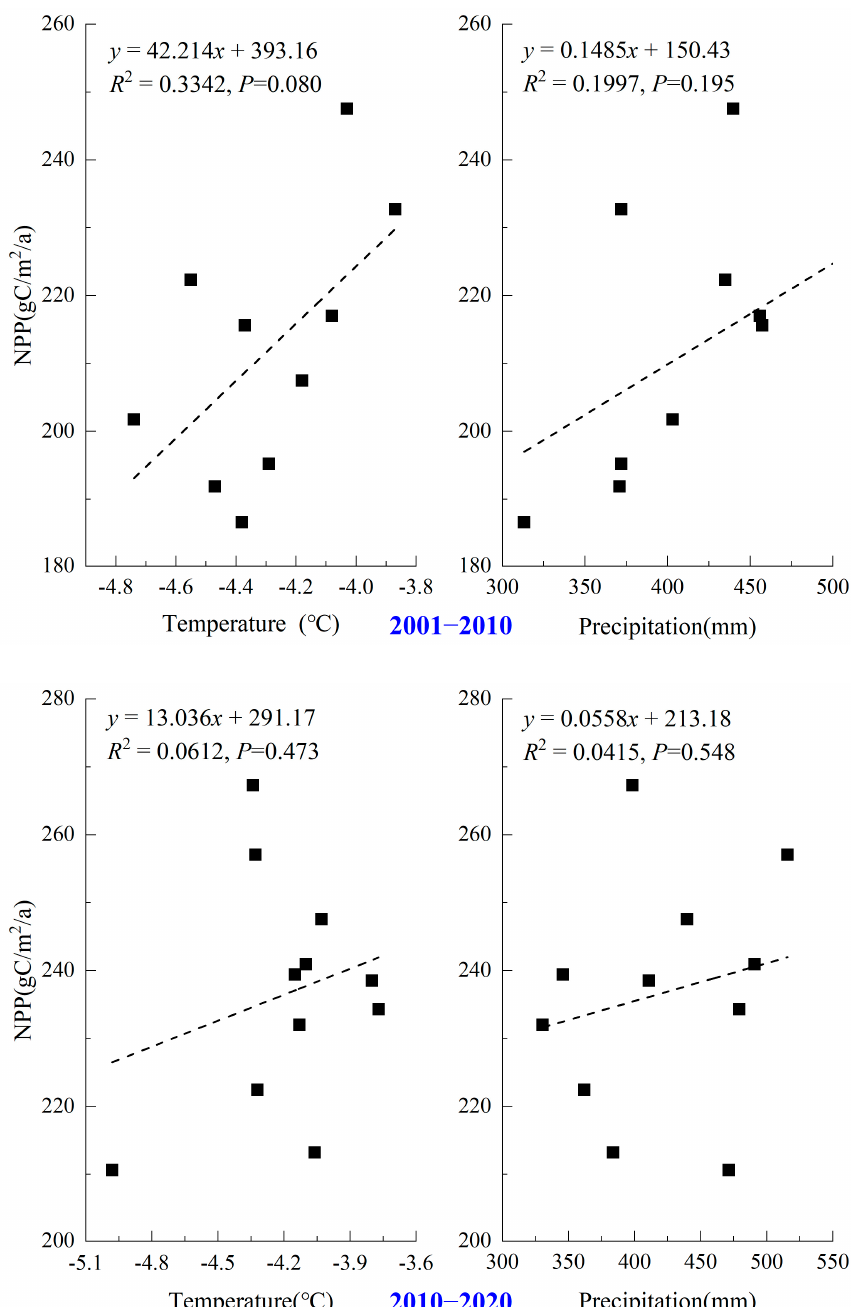
Figure 6. Scatter plot of net primary productivity (NPP), temperature, and precipitation in the Qinghai Lake Basin from 2001 to 2020.